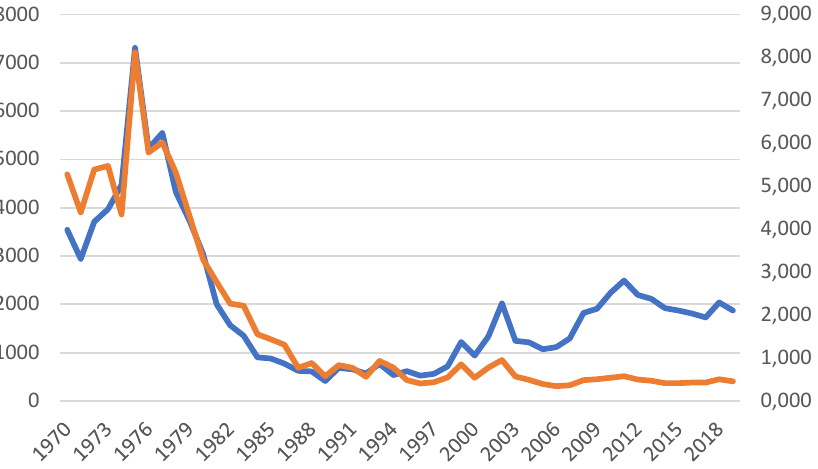
Figure 1. Military spending in million USD (blue line, left axis) and as a percentage of GDP (orange line, right axis).